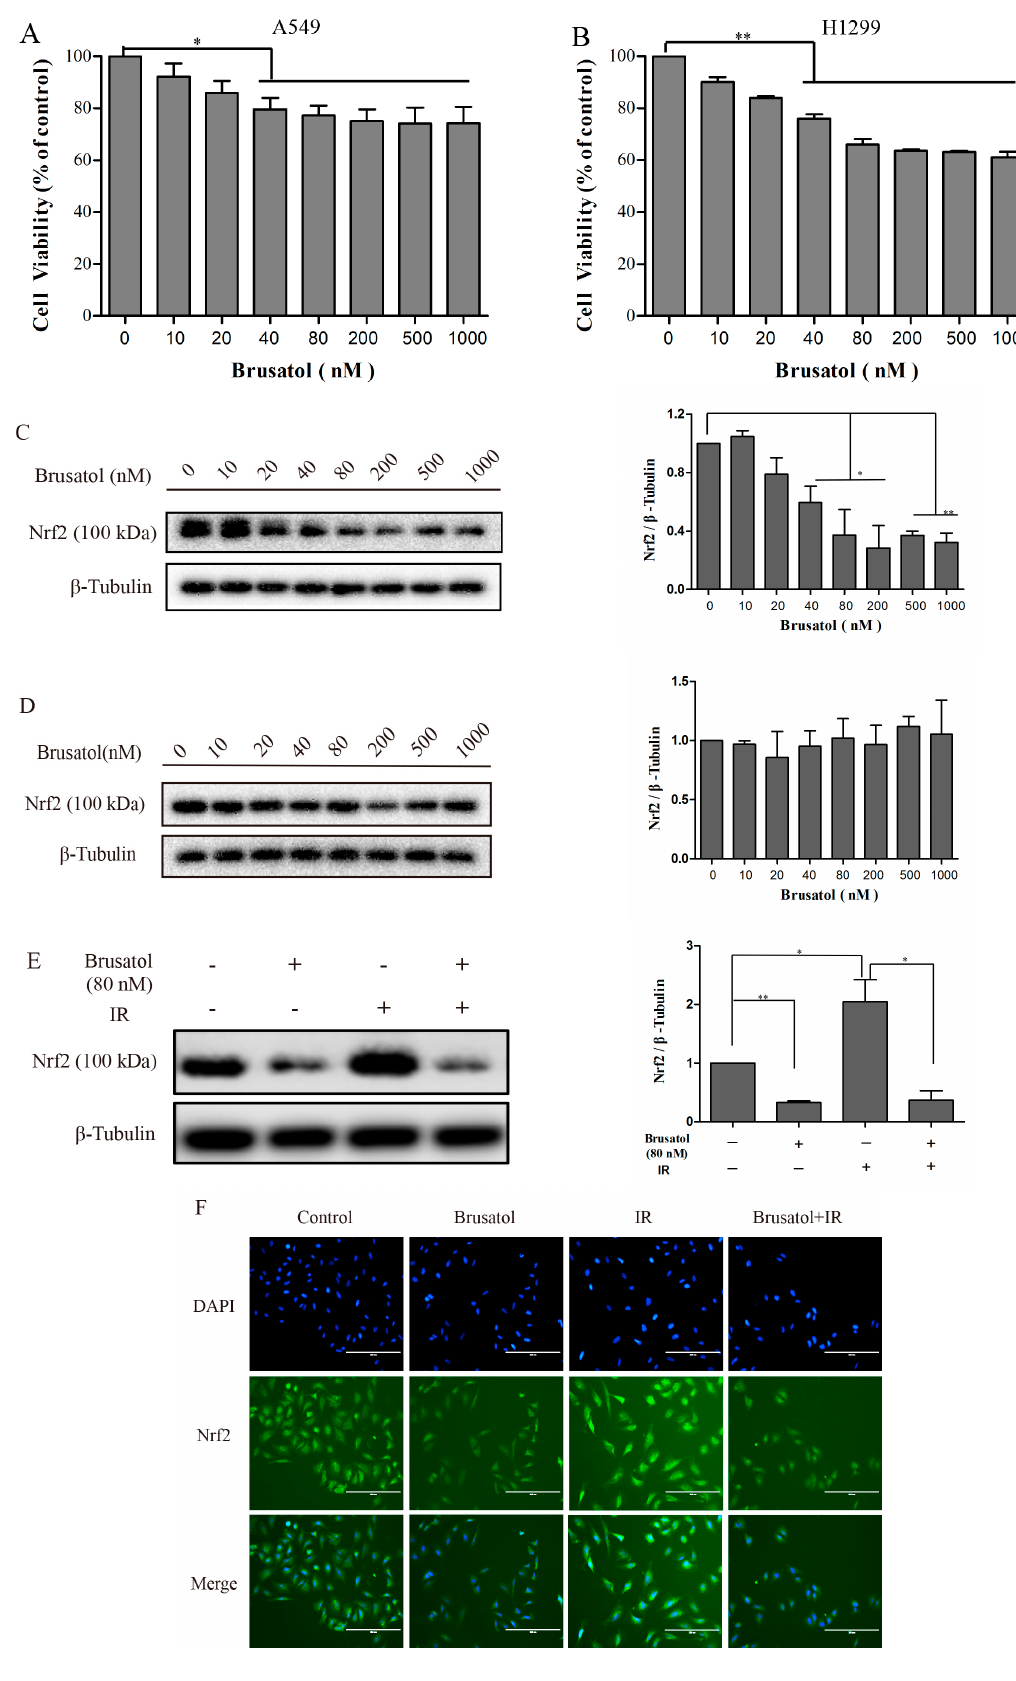
Figure 2. Cont. Figure 2.